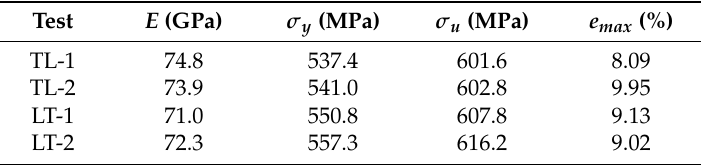
Table 4. Mechanical properties of Al7075-T651.